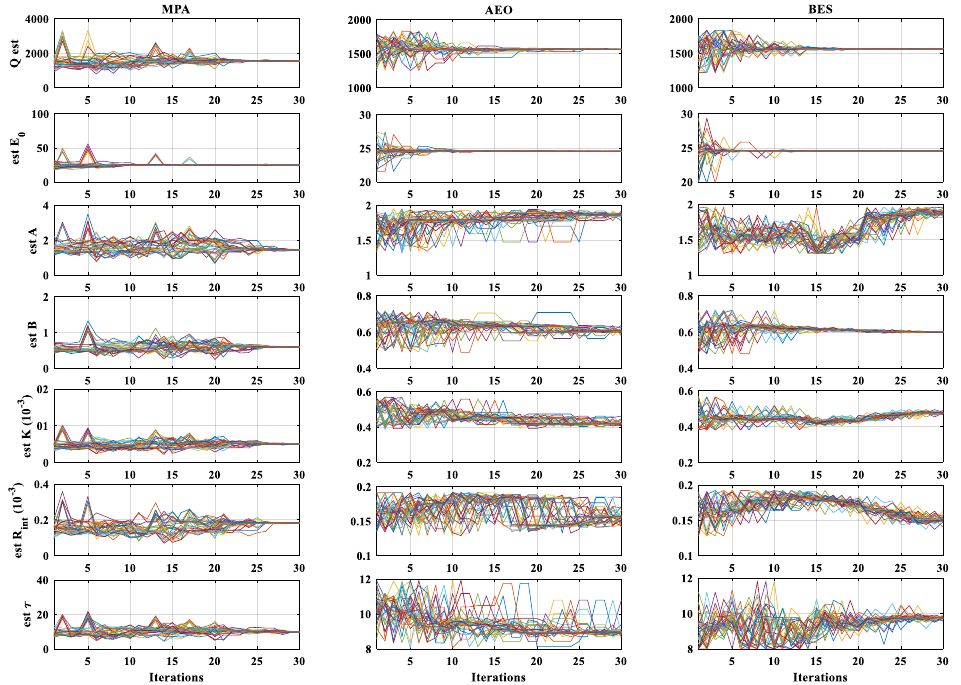
Figure 5. The evolution of MPA, AEO, and BES during the optimization process.